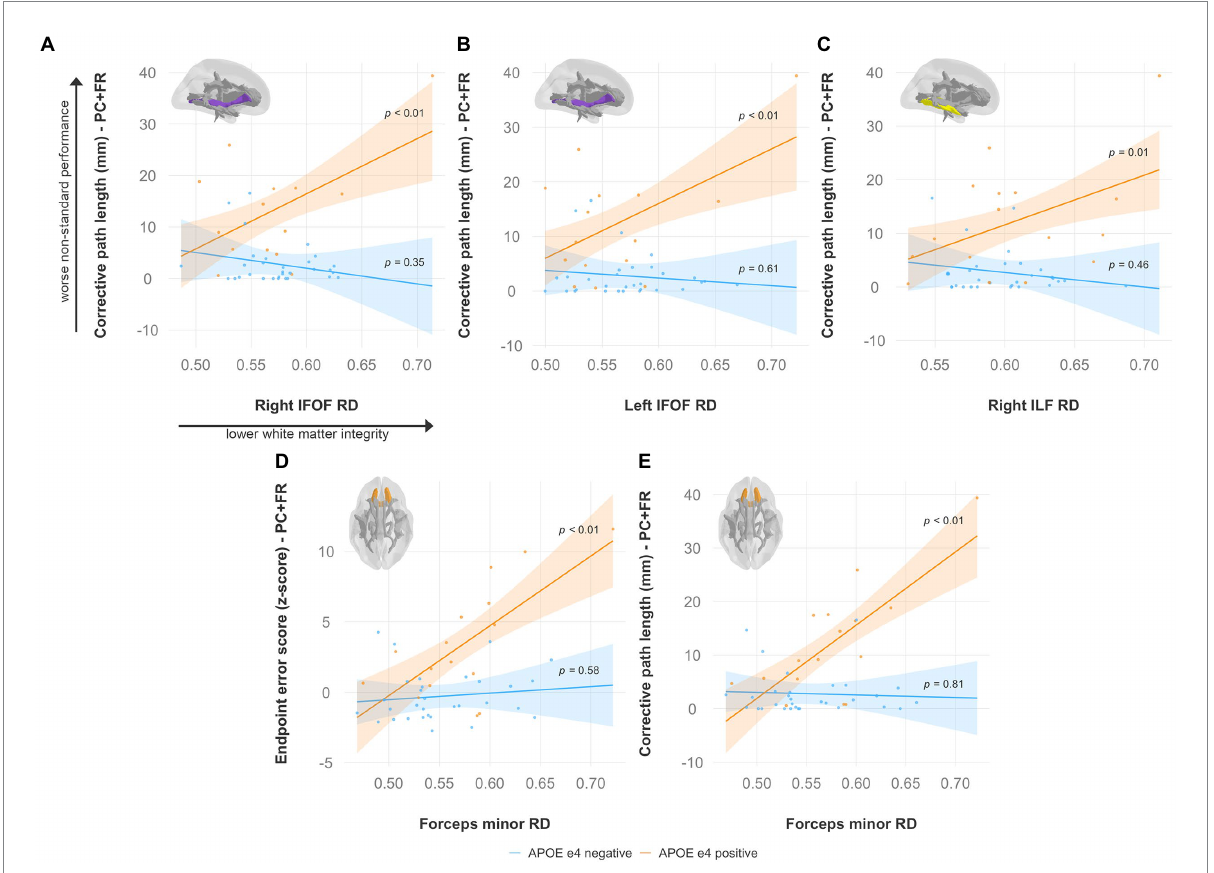
FIGURE 8 Higher radial diffusivity predicts worse visuomotor performance (reflected by higher endpoint error scores or corrective path lengths) in the plane- change feedback reversal condition only in APOE e4 carriers in several major white matter tracts, including the (A) right IFOF, (B) left IFOF, (C) right ILF, and (D,E) forceps minor. Significant results shown from multiple regression and simple slopes analyses. Brain figures made with “ggseg” R package (Mowinckel and Vidal-Piñeiro, 2020). PC + FR, plane change feedback reversal condition; APOE, apolipoprotein E; RD, radial diffusivity; IFOF, inferior fronto-occipital fasciculus; ILF, inferior longitudinal